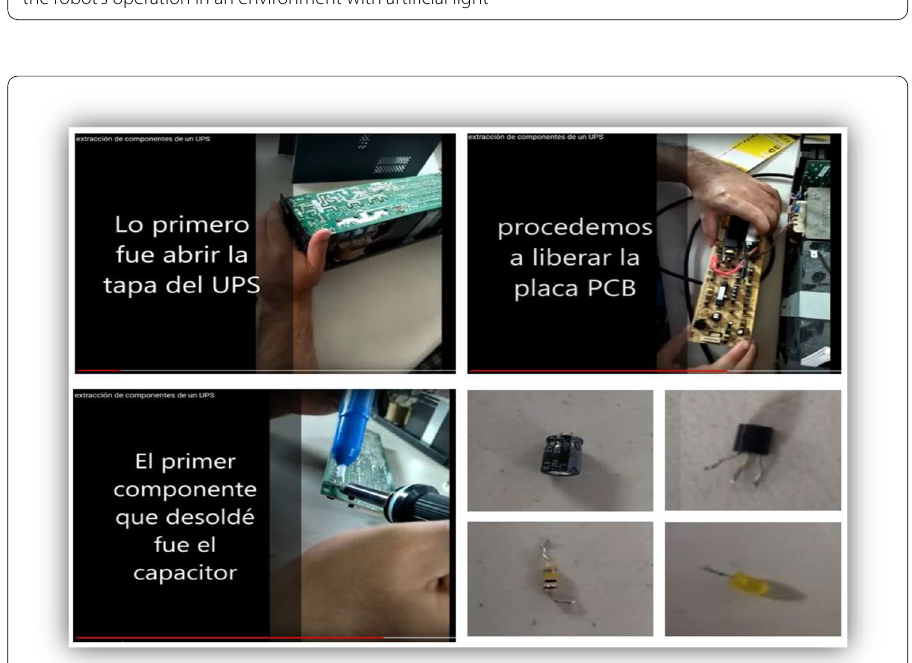
Fig. 14 Images of a video of the activity: “Recycling the WEEEs.” The student explains the disassembly of WEEE (UPS) and the extraction process (desoldering) of different usable parts for the construction of the BEAM robot: capacitors, transistors, resistors, and